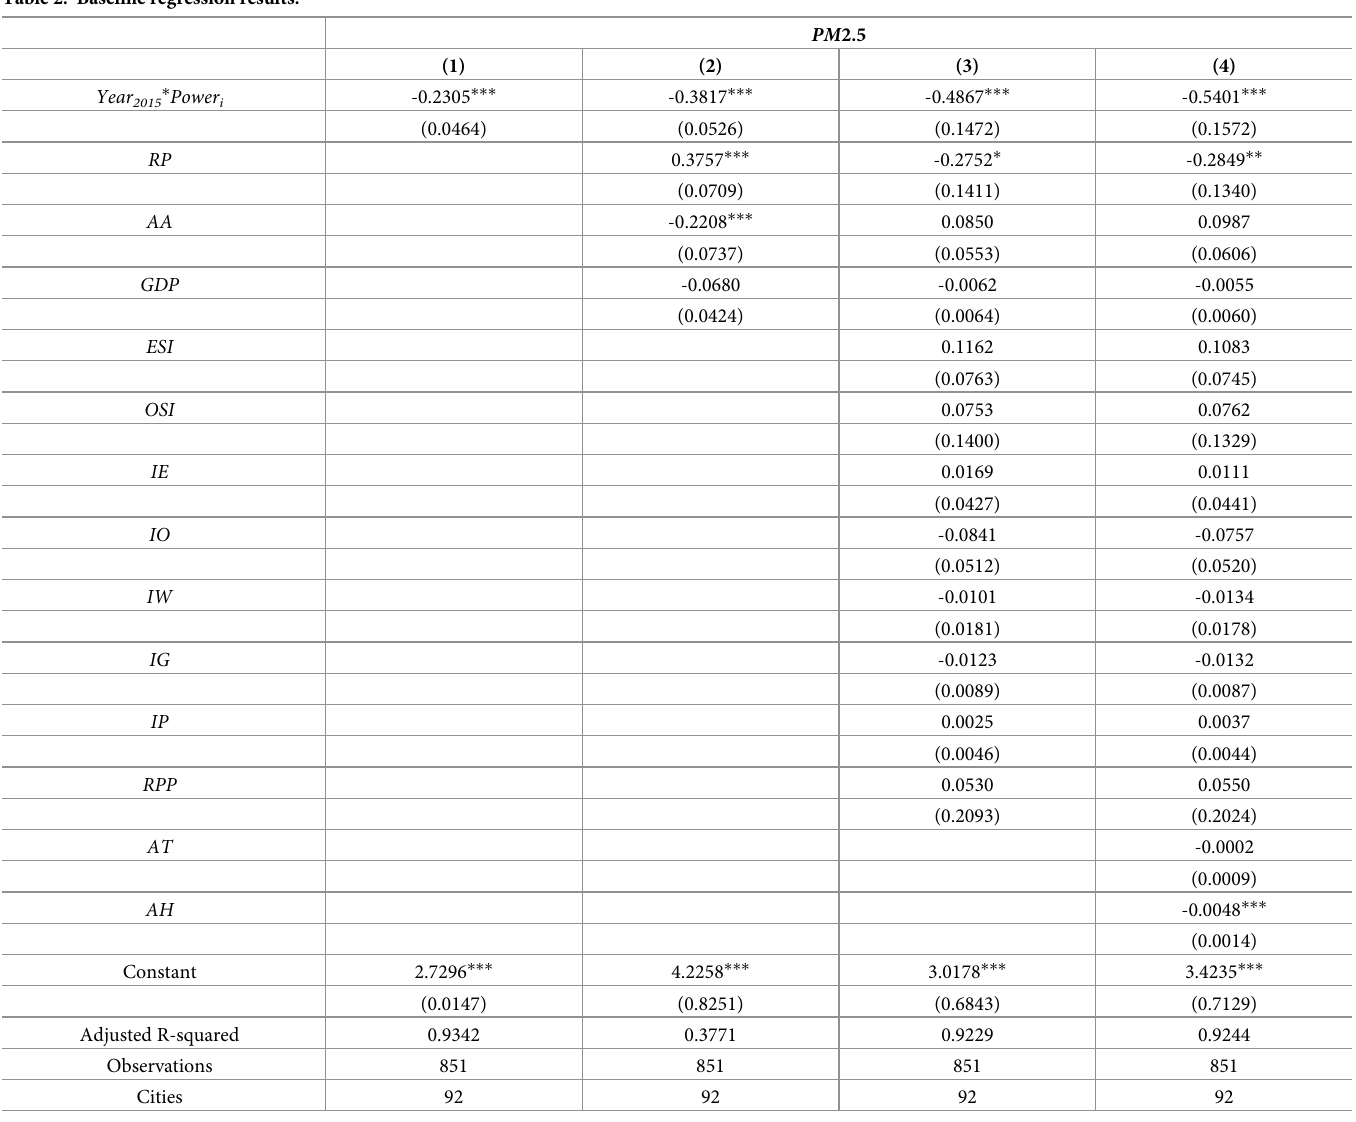
Table 2. Baseline regression